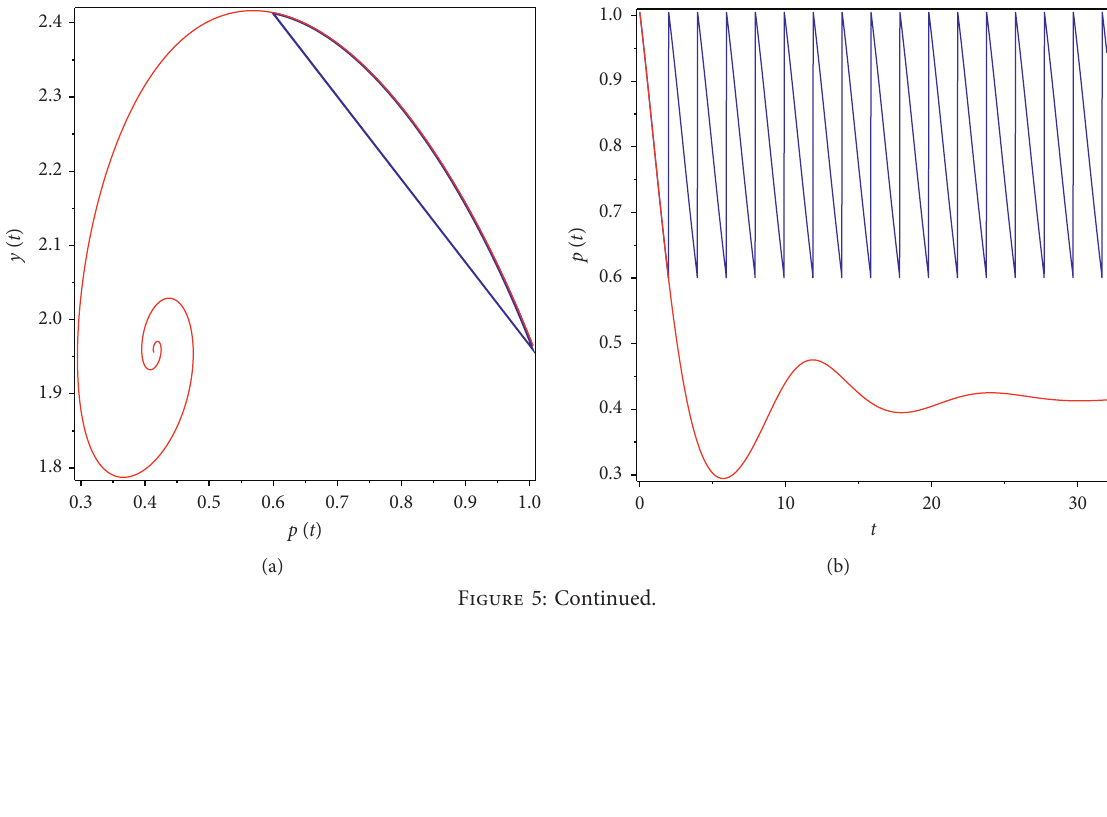
y + > y + > y + ≥ F M ( y A ) . (b) y A ≥ y + A ≥ 1 0 2